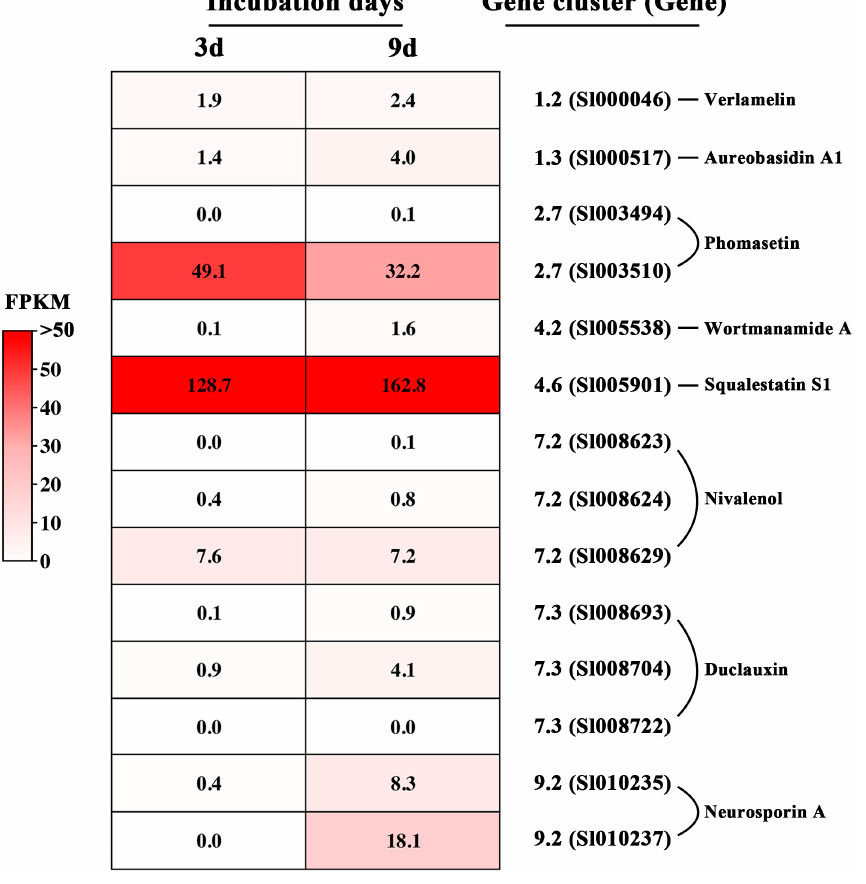
Figure 4. Heat map showing expression of the backbone genes for biosynthesis of eight known secondary metabolites in Simplicillium lamellicola JC-1 based on RNA